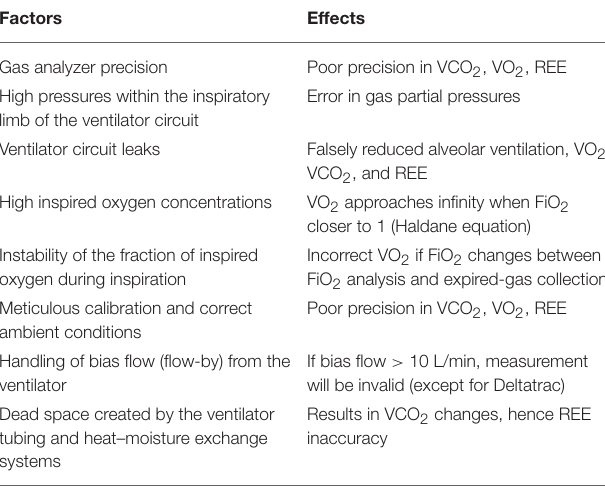
TABLE 1 | Considerations for indirect